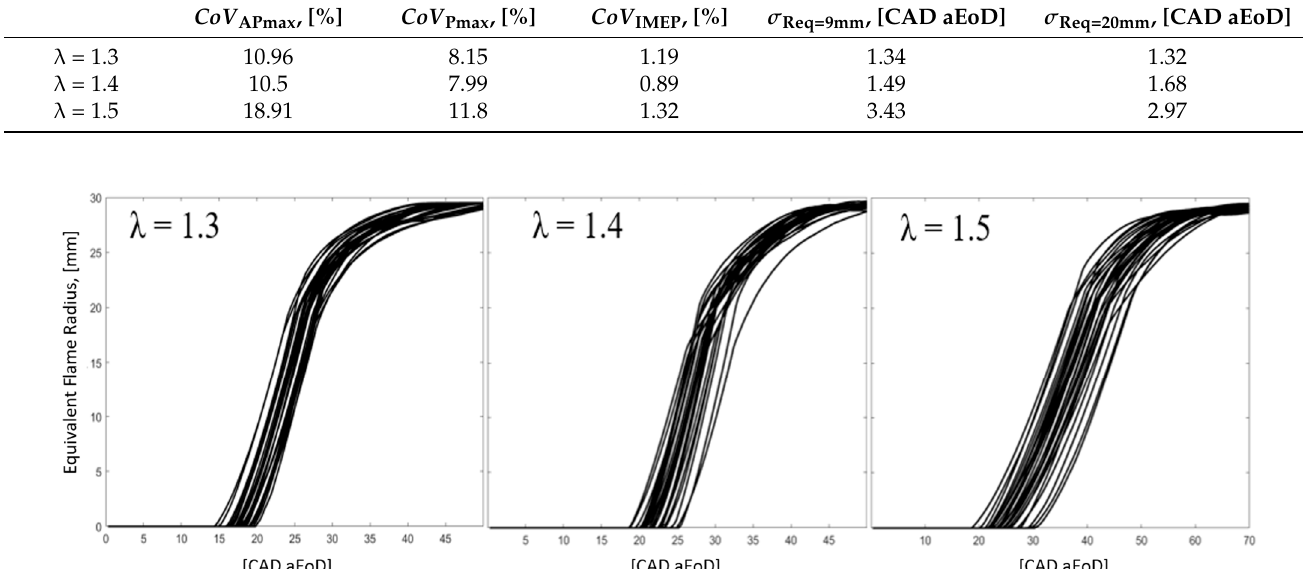
Figure 12. Equivalent flame radius of the cases used for the training session at each λ value analyzed.